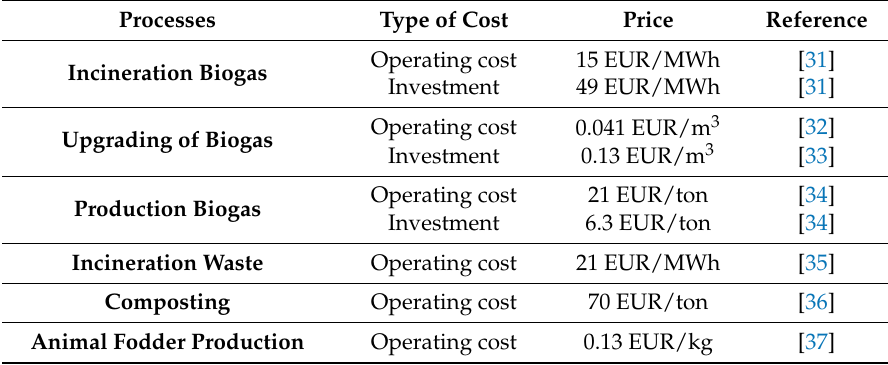
Table A3. Costs associated with production in the